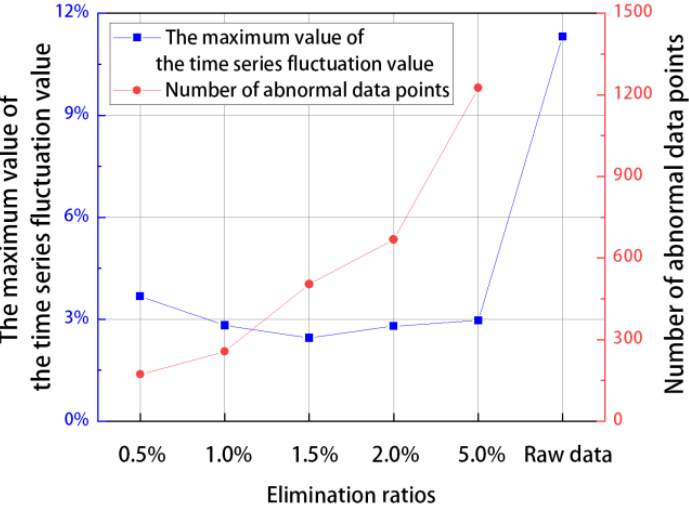
Figure 5. Calculation results of different elimination ratios.